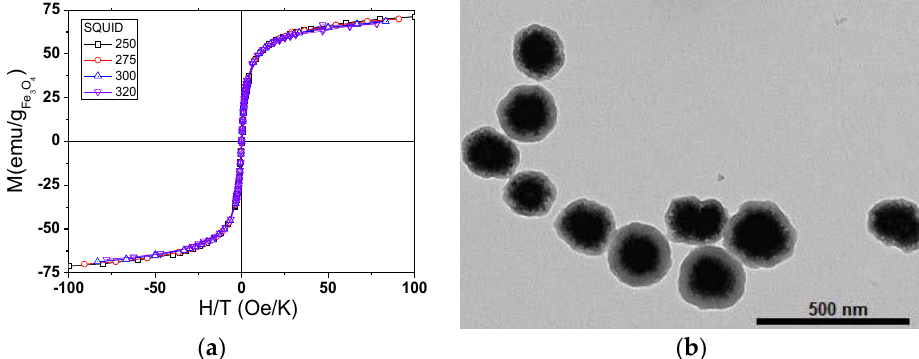
Figure 2. ( a ) Overlapping into a single curve of magnetization data versus H / T, that correspond to measurements performed corresponding from 250 to 320 K, on a dried sample of SPM multi-core Fe 3 O 4 @C, showing negligible remanence and coercive forces and ( b ) Transmission electron microscopy (TEM) micrograph of multi-core Fe 3 O 4 @C, with averaged size 187 nm. (Figures reprinted with permission from [25], IEEE, 2016).